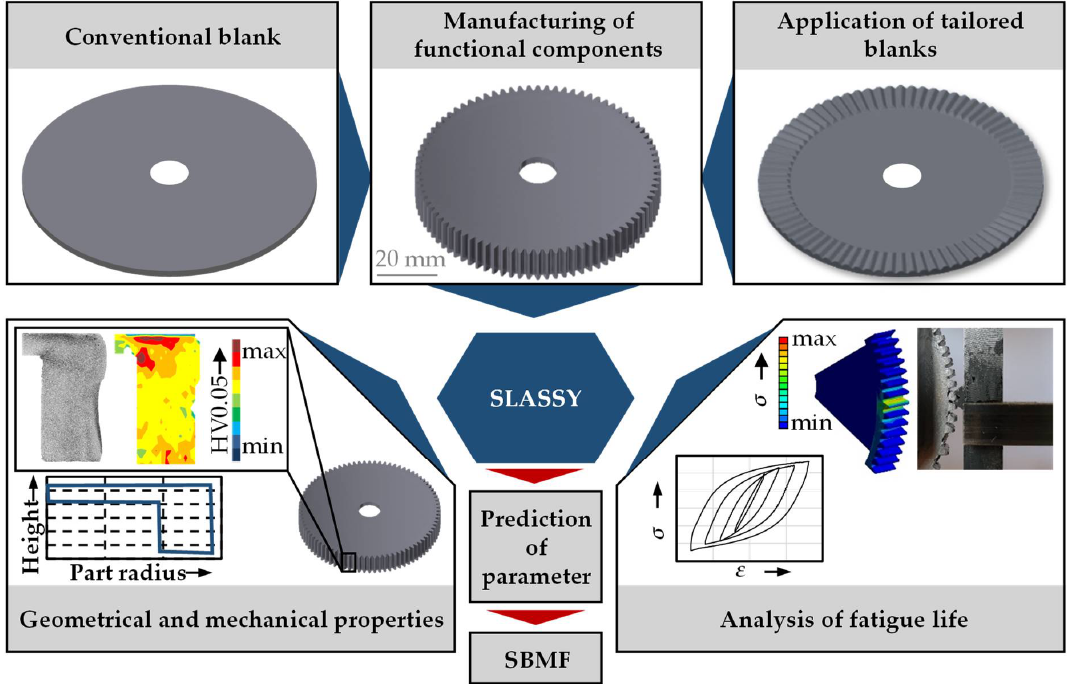
Figure 1. Applied methodology within the present